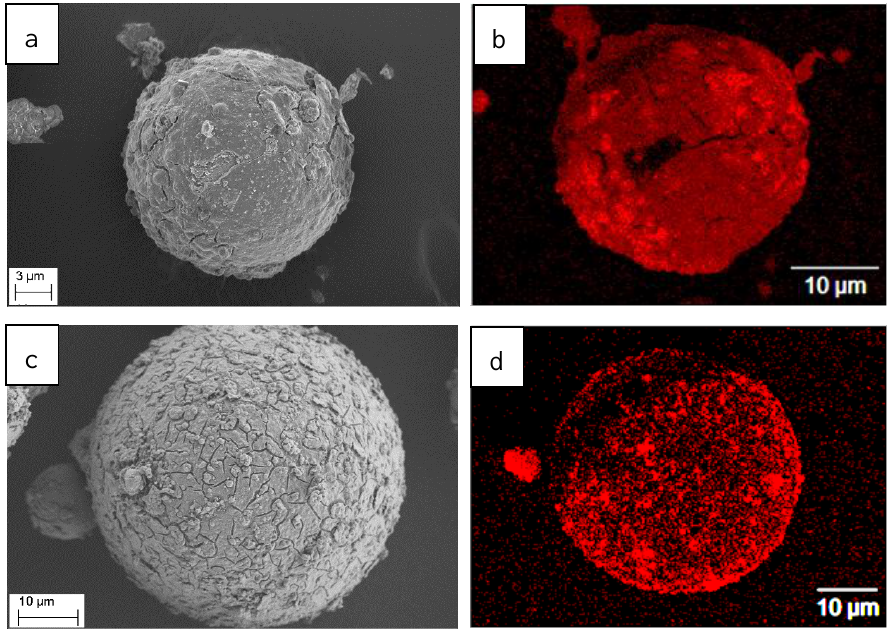
Figure 8. SEM images and EDX-Measurements of MHGS (( a,b ): iM16K-ZF and ( c,d ): S38HS) coated via LPD-process in a rotating flask (defined volume: 6.5 mL, Experiment 2 B). In comparison to the reference spheres, a more structured aluminum coating could be obtained on both types of spheres.